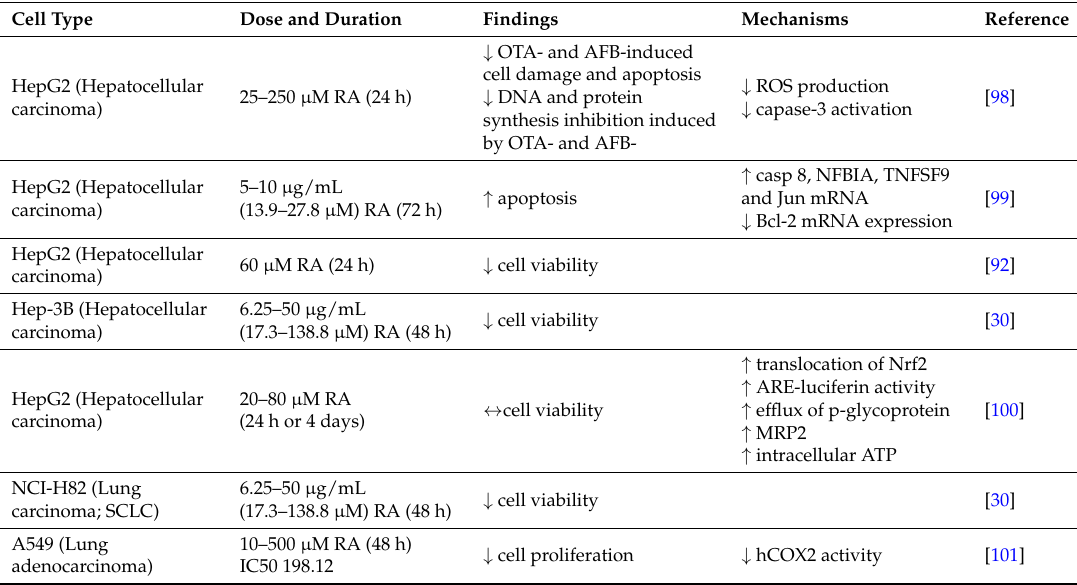
Table 14. Anticancer effects of Rosmarinic Acid (RA). In vitro studies: liver and lung cancer.